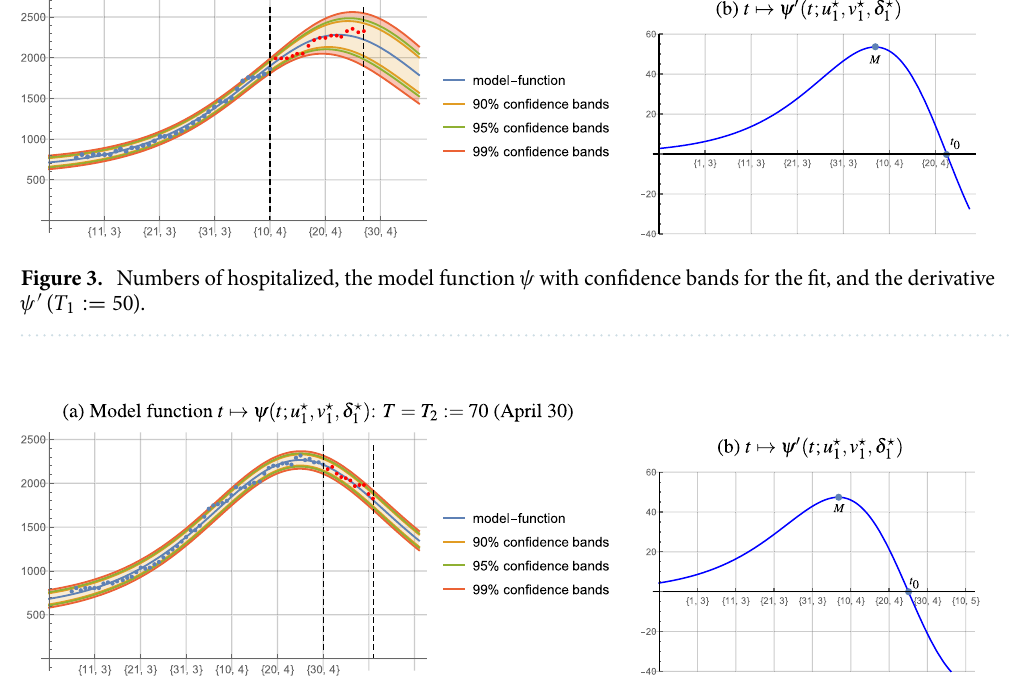
Figure 4. Numbers of hospitalized, the model function ψ with confidence bands for the fit, and the derivative 70 ψ ′ ( T 2 :=